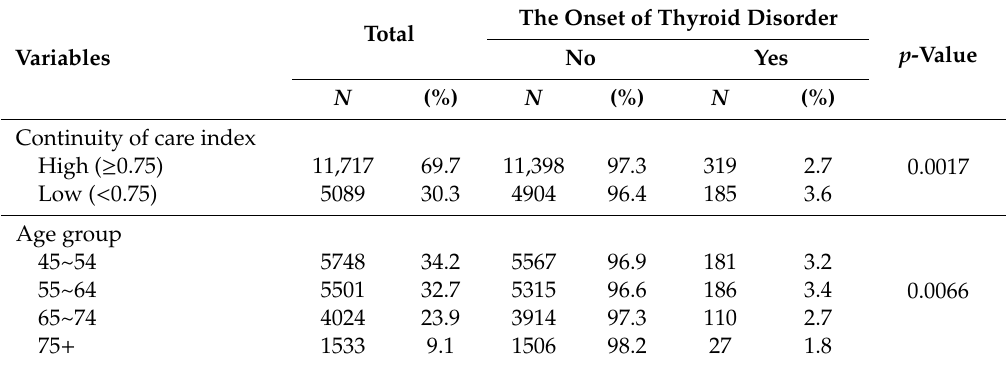
Table 1. The general characteristics of the study